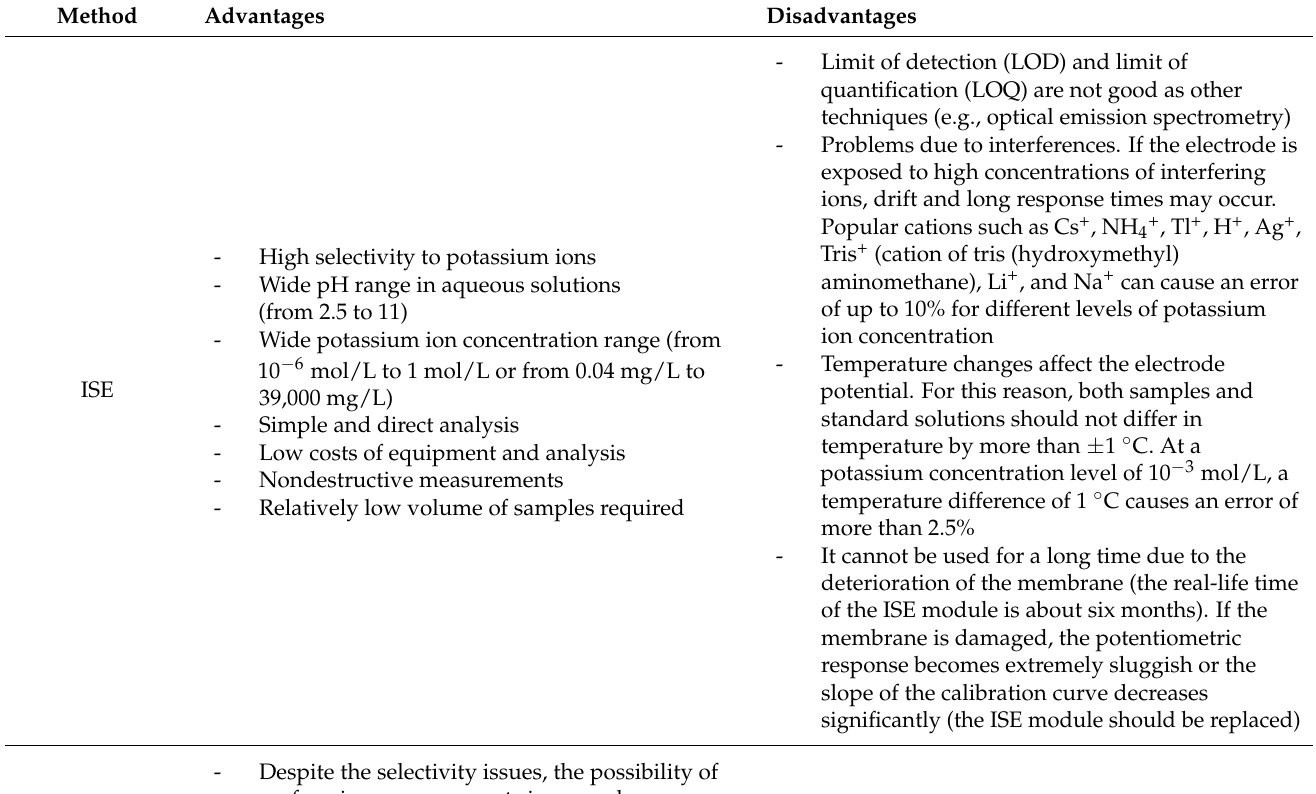
Table 11. Advantages and disadvantages of ion-selective electrode (ISE) and microwave-induced plasma with optical emission spectrometry (MIP-OES)